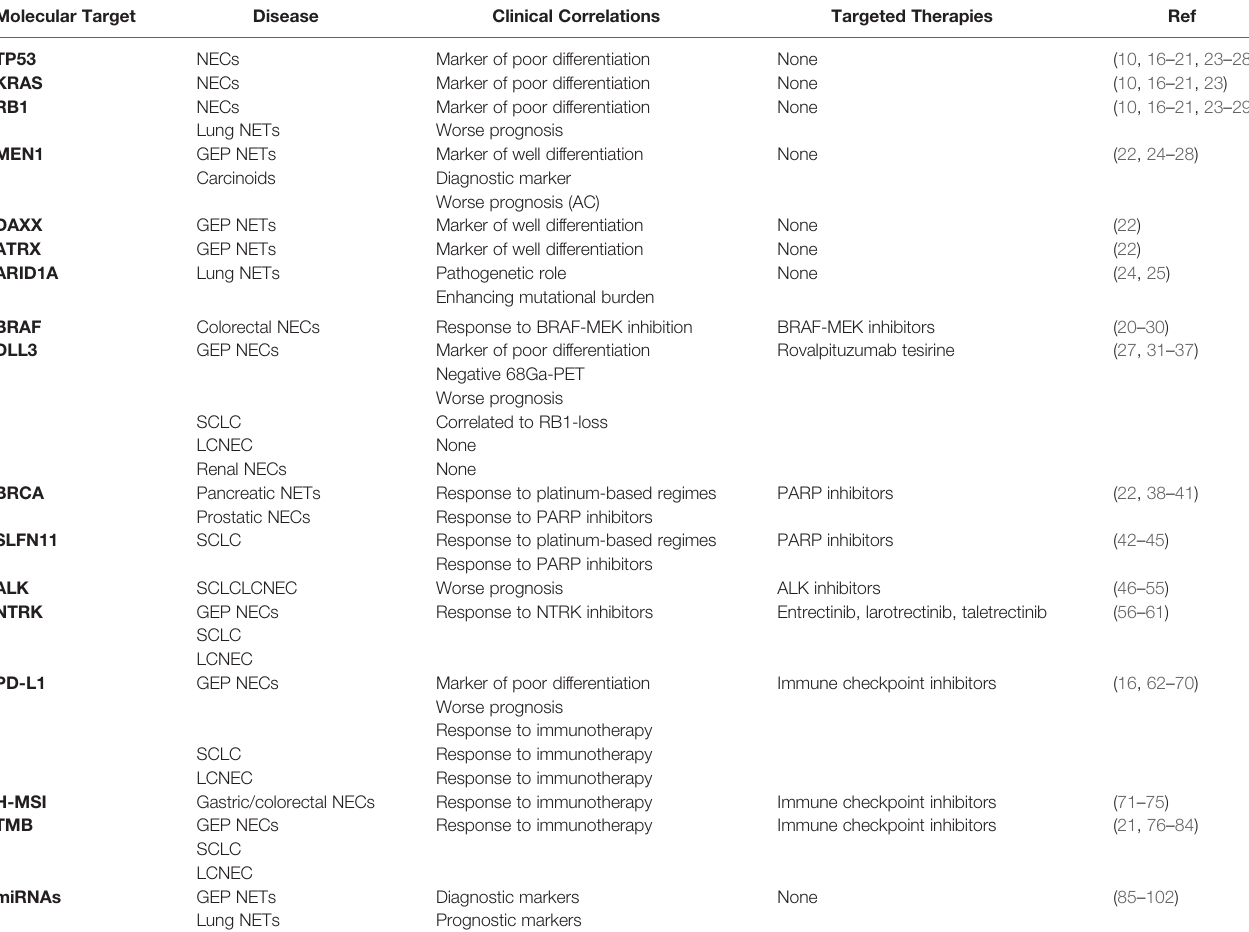
TABLE 1 | Potential novel biomarkers in high-grade NET and relative therapeutic agent.